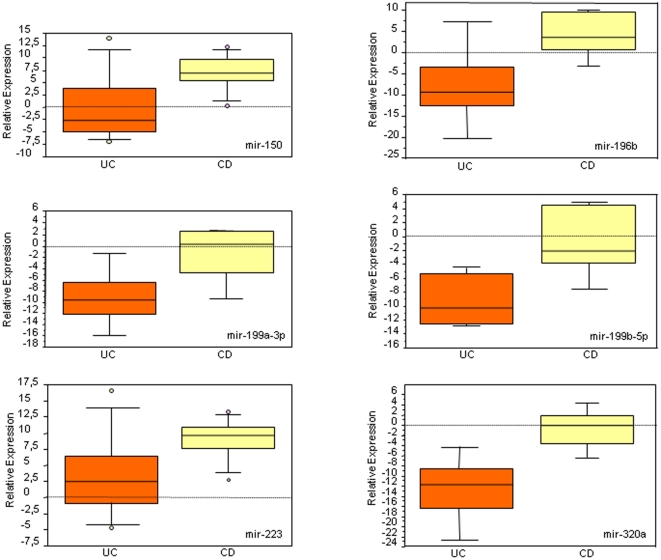
miRNAs with differentially altered expression in non-inflamed UC and CD tissues : Box-whisker plot analysis.miRNA expression was measured in non-inflamed colonic mucosa obtained from UC and CD patients (8 patients/IBD) and computed vs. that measured in healthy controls. Data corresponding to 6 miRNAs (mir-150, mir-196b, mir-199a-3p, mir-199b-5p, mir-223 and mir-320a) with statistically different alteration of expression in UC and CD mucosal tissues are presented as box-whisker plots [78] (box, 25–75%; whisker, 10–90%; line, median); p<0.05.